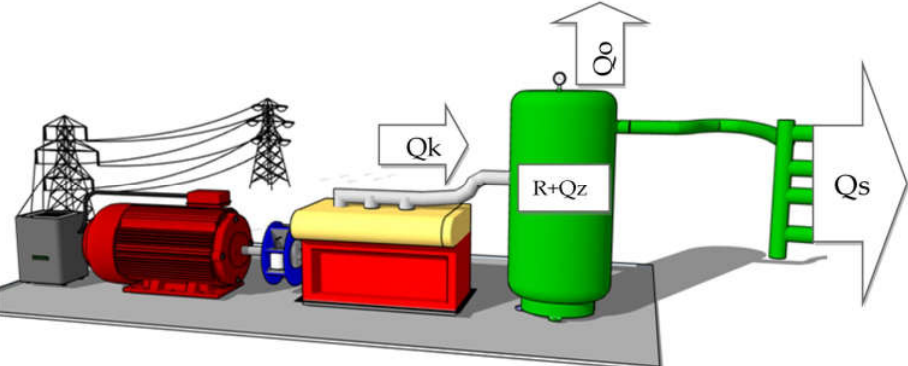
Figure 1. Scheme of piston compressor drive system.